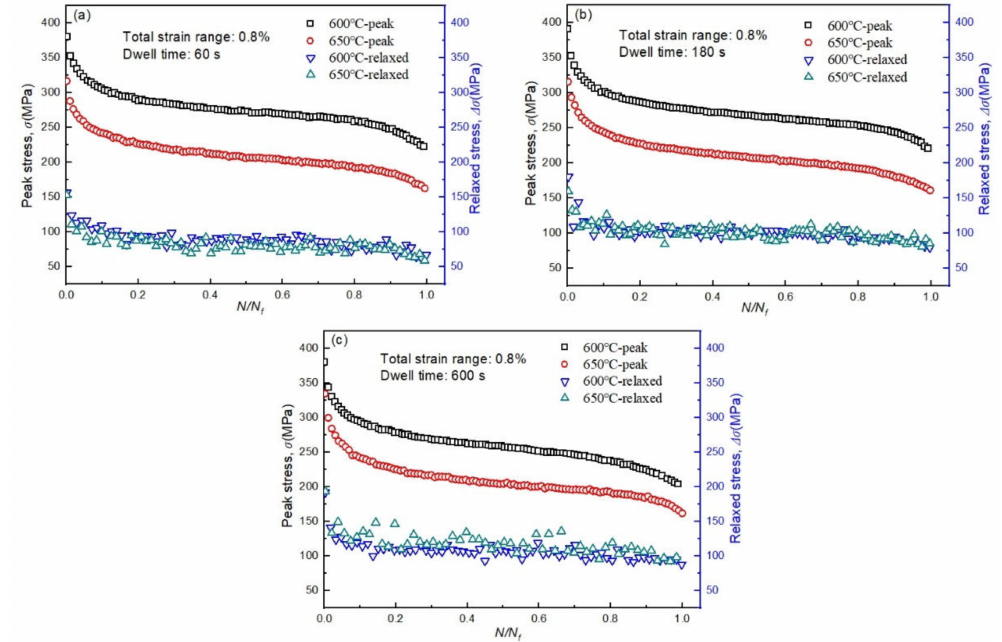
Figure 6. The evolution of peak stress and relaxed stress at di ff erent temperatures 600 and 650 ◦ C, and dwell times ( a ) 60 s, ( b ) 180 s and ( c ) 600